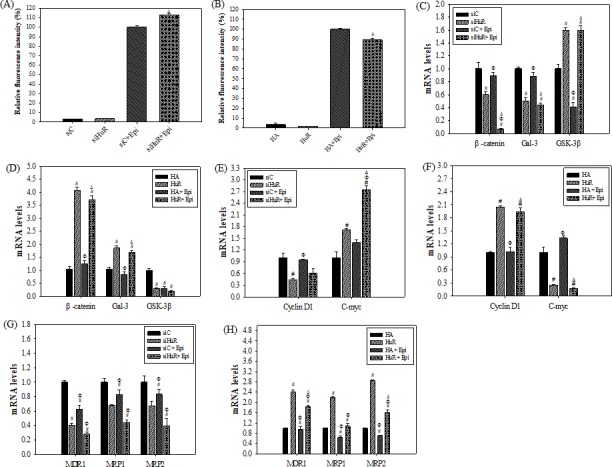
HuR modulated the intracellular Epi accumulation by regulating the expressions of genes associated with β-catenin/GSK-3β pathway, oncogenes, and MDR transporters in SW620 cells.(A-B) HuR silencing or overexpression affected the intracellular accumulation of Epi in SW620 cells. SW620 cells were transfected with 75 nM siC or siHuR (A) or with 2μg HA or HuR (B). After 24 h, cells were treated with Epi (5 μg/ml) for 24 h. The relative fluorescence intensity of each group in the cells was measured by flow cytometry. It was calculated by setting the fluorescence intensity of siC + Epi (A) or HA + Epi (B) group as 100%. Data are presented as mean percentages ± S.D. from three independent experiments. ΔP<0.05 compared to the siC + Epi (A) or HA + Epi (B) group. The relative fluorescence intensity % of siC, siHuR, HA, and HuR were also shown here to demonstrate that the auto-fluorescence of siC, siHuR, HA, and HuR was negligible. (C-D) HuR knockdown or overexpression affected the mRNA expressions of β-catenin/GSK-3β pathway-related genes, including galectin-3, GSK-3β, and β-catenin in SW620 cells. (E-F) HuR knockdown or overexpression affected the mRNA expressions of oncogenes, such as cyclin D1 and c-Myc in SW620 cells. (G-H) HuR silencing or overexpression affects the mRNA expressions of MDR transporter-related genes in SW620 cells. For (C-H), the cells were transfected with 75 nM siC or siHuR (C, E, G), or 2 μg HA or HuR (D, F, H), separately. After 24 h, the cells were treated with Epi (5 μg/ml) for 24 h. RNA was extracted from the cells as treated above for measurement of mRNA expressions by real-time PCR. The relative expression levels of genes were calculated by setting siC (C, E, G) or HA (D, F, H) group as 1, respectively. Means ± S.D. from three independent experiments were plotted. #P<0.05 compared to the siC or HA group; ΦP<0.05 compared to the siHuR or HuR group; ΔP<0.05.